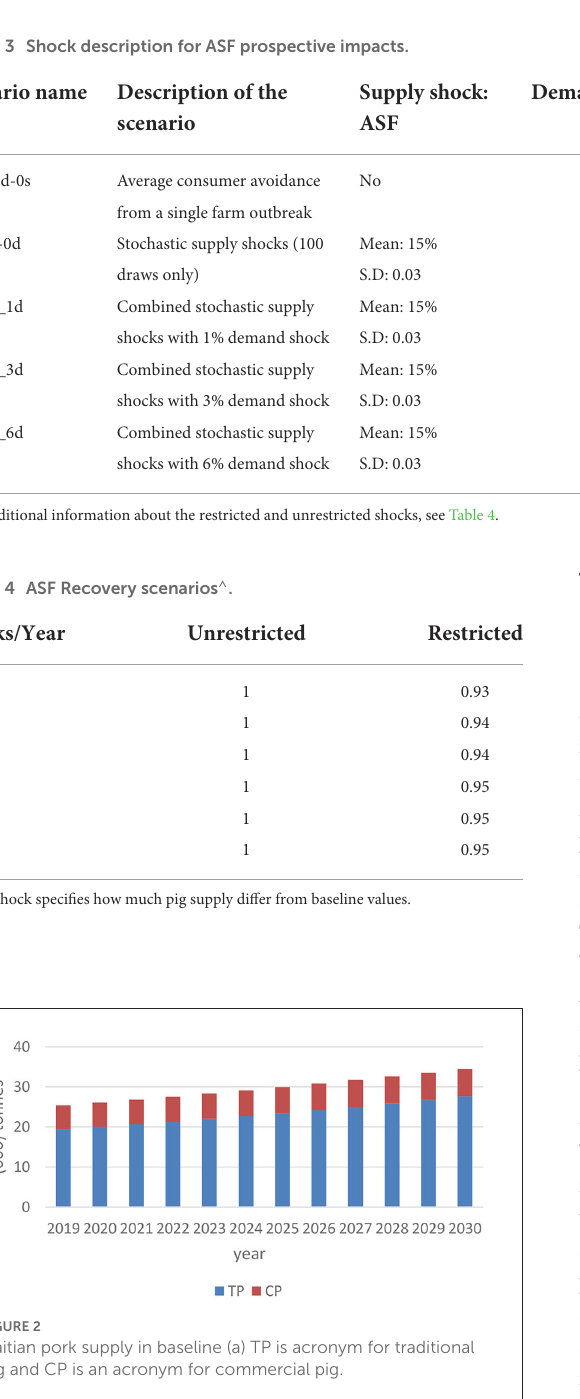
prices would have increased by an average of 4% per year. A faster average growth, 16% yearly, is noted in the traditional pig sector, stretching the sectoral price gap. By 2030, traditional pig price inflation will be 23 times higher than commercial